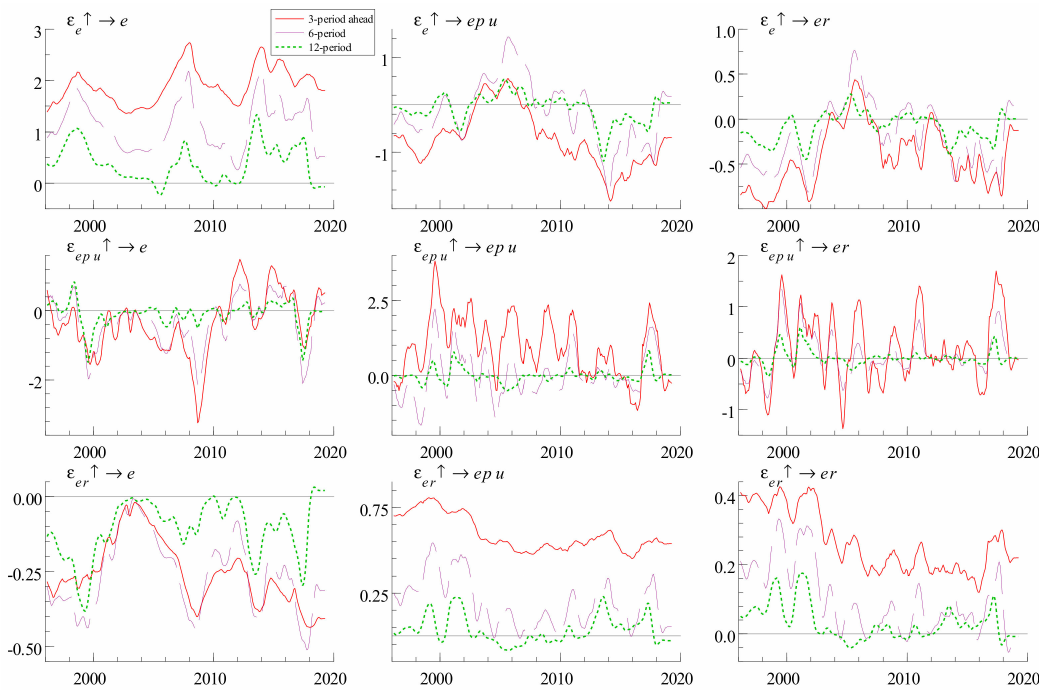
Figure 2. Time-varying impulse responses of the TVP-VAR